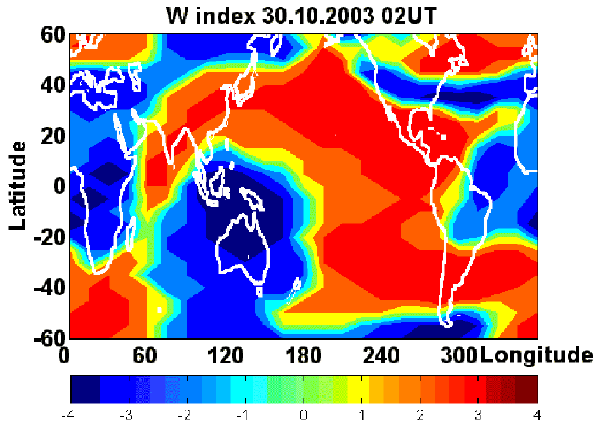
Fig. 1. Map of positive and negative ionospheric indices during the peak of the ionospheric super-storm on 30 October 2003 derived from the TEC global